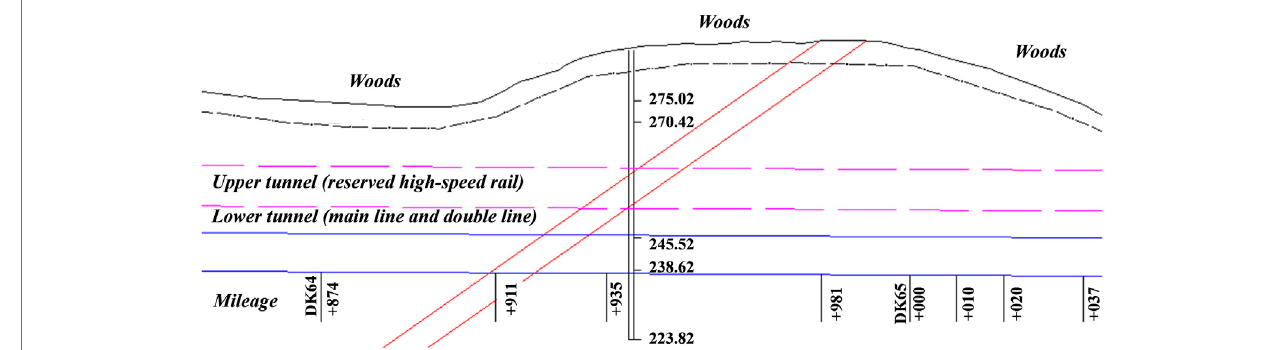
FIGURE 2 | Longitudinal relationship diagram of the upper and lower tunnels.